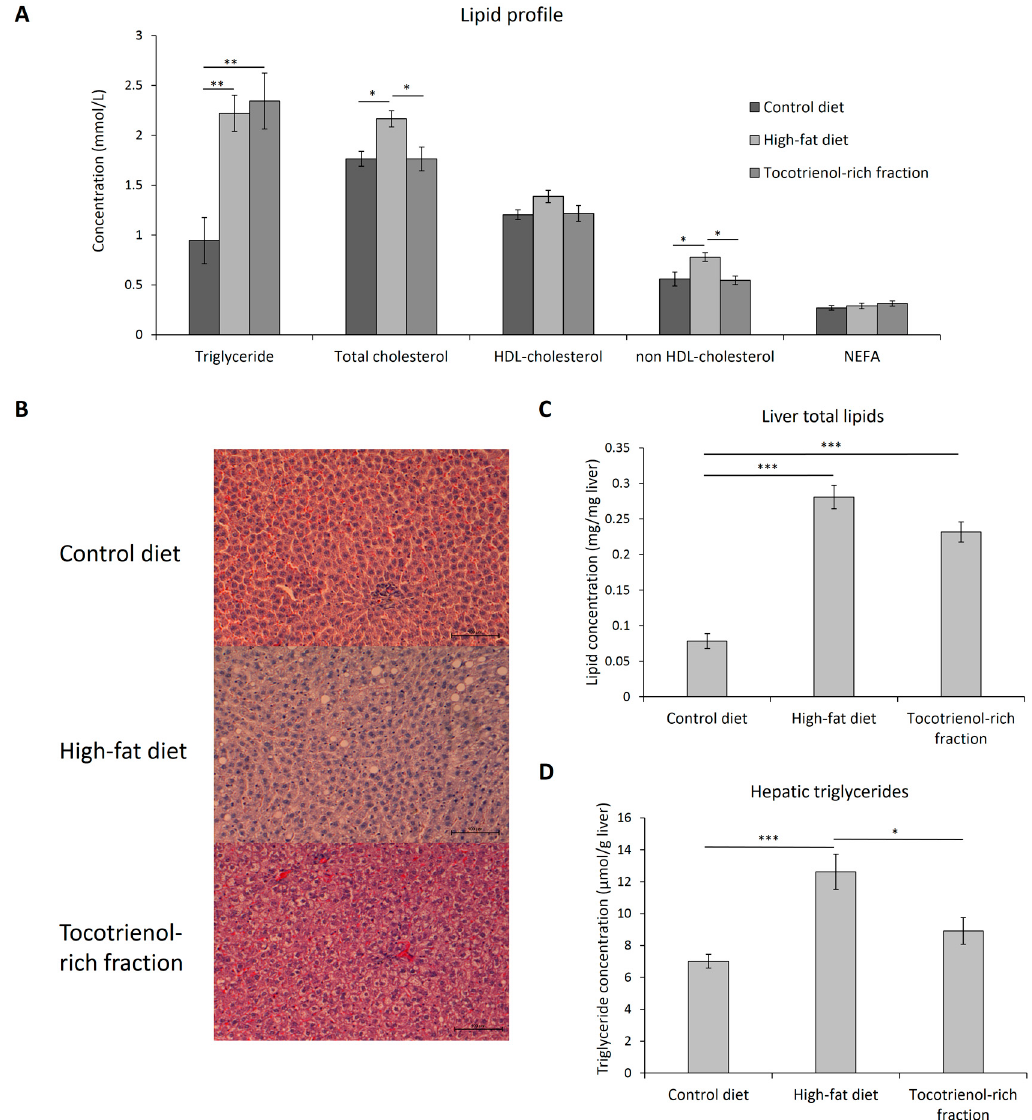
Figure 7. Lipid profile ( A ), including triglycerides, total cholesterol, HDL-cholesterol, non HDL-cholesterol and non-esterified free fatty acid levels of the rats assigned to different treatment groups at the end of treatment. The representative images of the H&E-stained liver tissue (x200 magnification) of each group are shown ( B ). The total lipids ( C ) and triglycerides ( D ) concentrations in the liver were quantified and illustrated in bar plots. Error bars indicate SEM. The sample size was n = 7 per group. * Indicates p < 0.05, ** Indicates p < 0.01 and *** Indicates p < 0.001 between groups. HDL, high density lipoprotein; NEFA, non-esterified fatty acid.